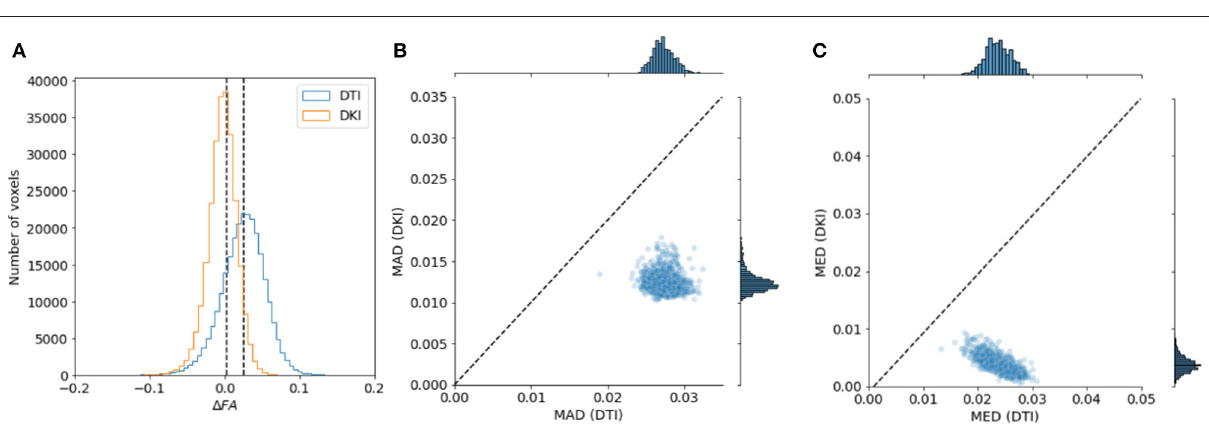
FIGURE 9 | Comparing DTI And DKI FA variability in the Human Connectome Project dataset. We compared FA for DTI and DKI in different subsets of the data , divided by b-value. In each voxel in the white matter, we computed the difference in FA ( 1 FA) between the subsets and quantified the properties of the distribution of 1 FA. (A) For example, within a representative subject, we find that the median absolute difference (MAD) is smaller for DKI than for DTI (the distribution of 1 FA is narrower). We also find that the median 1 FA is closer to 0. This is consistent in all of the subjects in the sample, both for MAD (B) and for median (C)